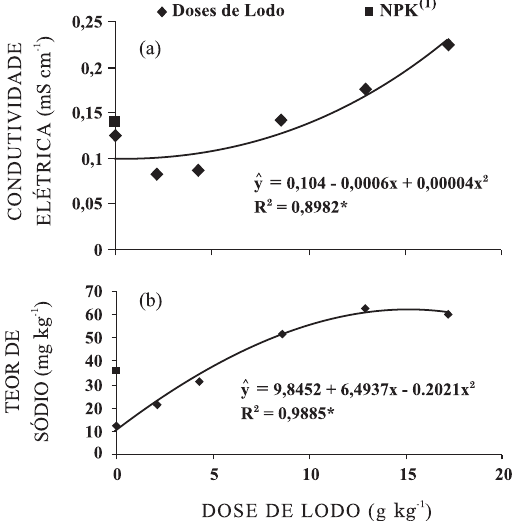
regressão.Figura 2. Variação da condutividade elétrica (a) e